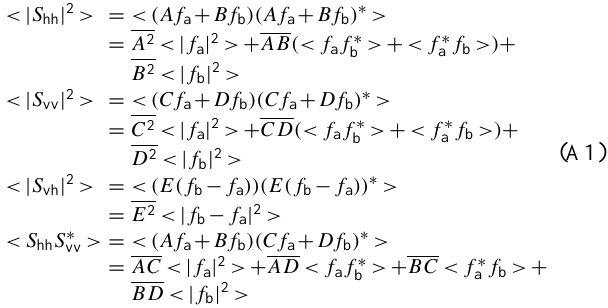
Fig. 7. The estimator bias versus the rain rate.